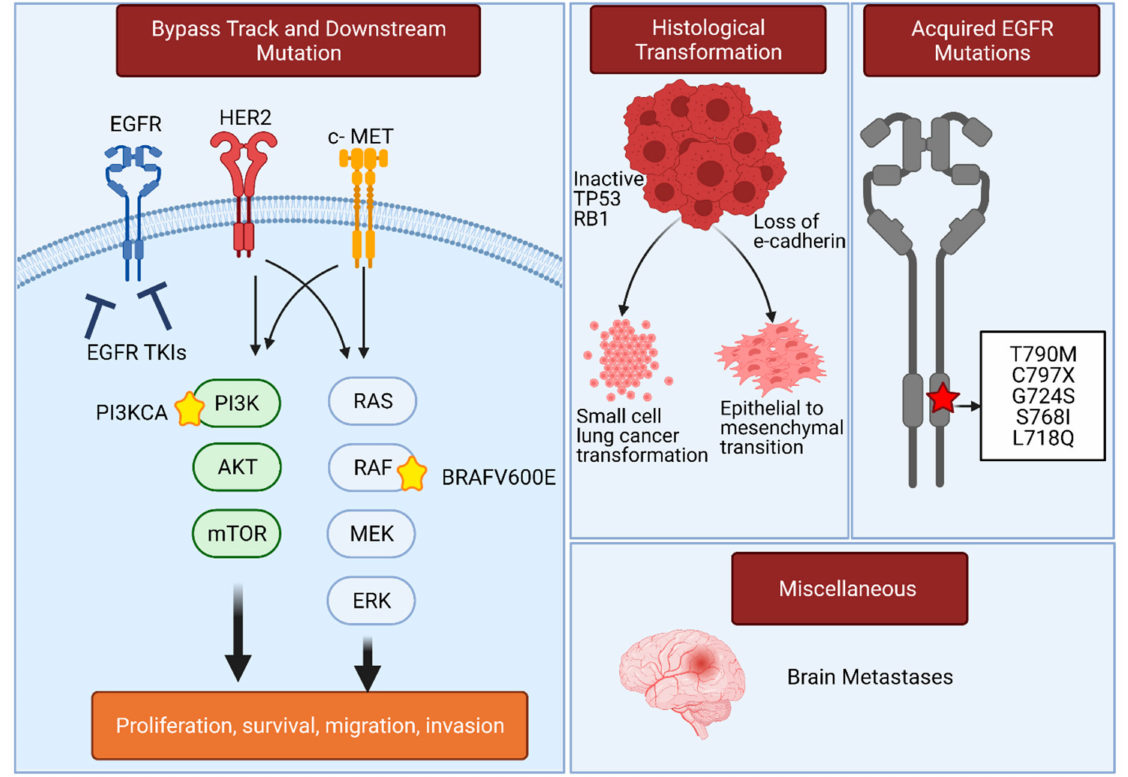
Figure 5. Common resistance mechanisms to EGFR TKIs in EGFR-mutated lung adenocarcinoma. Bypass track signaling include HER2 and c-MET amplification that can lead to parallel activation of downstream signaling, which is able to drive tumor proliferation despite EGFR inhibition. Downstream point mutations increasing activity of the EGFR effector kinases PI3KCA and BRAF V600E can also lead to a constitutive activation of cancer growth. Histological transformation to SCLC, or epithelial to mesenchymal transition (EMT), contribute to loss of sensitivity to EGFR TKIs in lung adenocarcinoma. Acquired EGFR mutations in the tyrosine kinase domain can lead to increased affinity to ATP versus EGFR TKIs. Other mechanisms are also implicated in resistance to EGFR TKIs such as development of brain